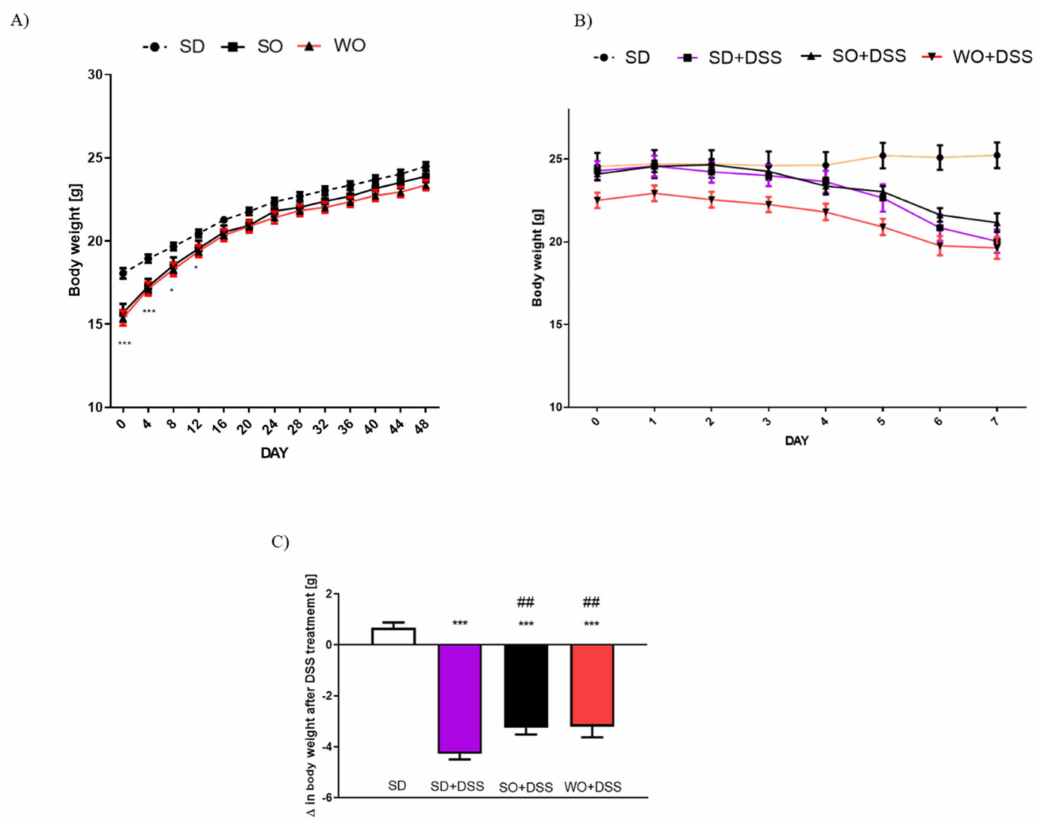
Figure 2. Data for body weight changes ( A ) in mice fed with standard diet (SD), SD supplemented with sunflower oil (SO), and SD supplemented with walnut oil (WO). Data for body weight loss in the course of dextran sulfate sodium (DSS) treatment ( B ) and overall change in body weight after 7 days of colitis ( C ). Data represent mean ± SEM, n = 28 per group ( A ); n = 8 per group ( B , C ); * p < 0.05, ** p < 0.01, *** p < 0.001, as compared to SD; ## p < 0.05, as compared to SD + DSS.